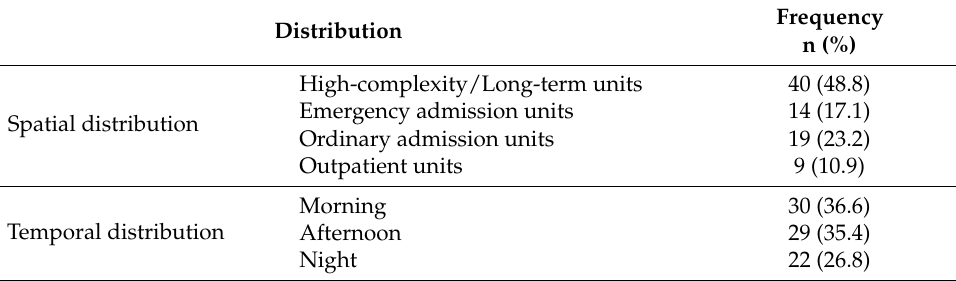
Table 5. Spatial and temporal distribution of aggressive